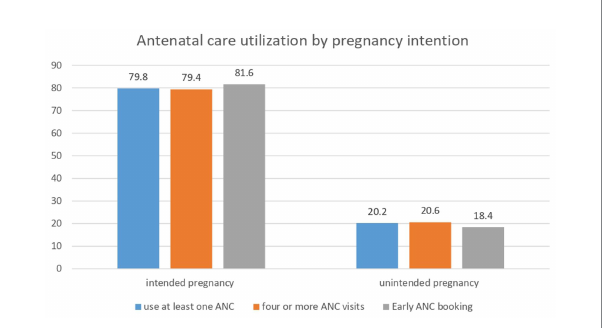
FIGURE 2 Antenatal care service utilization across pregnancy intention in Ethiopia, EDHS